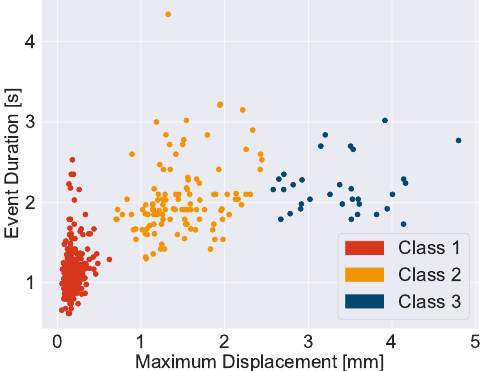
Figure 6. Scatterplot of the maximal vertical displacement vs. the event duration. The three classes can be distinguished.